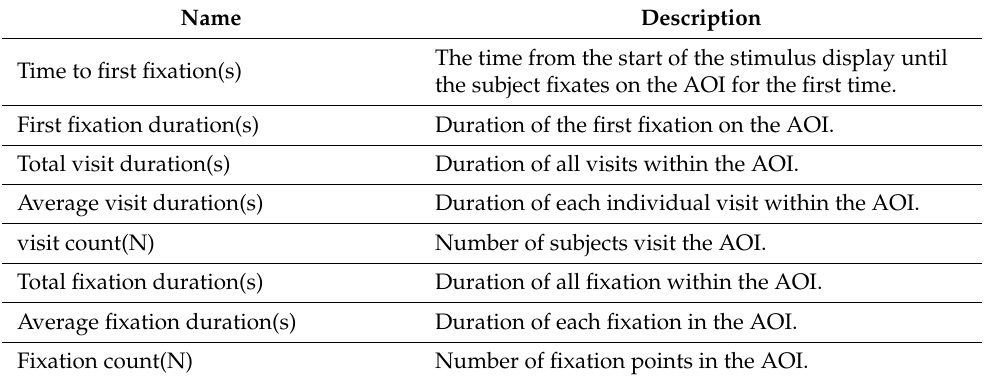
Table 1. Definition of eye movement